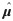
Dependence of popular impact metrics on the values of μ^ and number of publications N
p for researchers in chemistry.We generate 1000 synthetic datasets for each of 20 values of μ^ from 0.5 to 2.0, inclusive, and for N
p = 50 (blue) and N
p = 200 (red). We use the average σ^ of all researchers in chemistry. For each pair of values of μ^ and N
p we calculated the average value and 95% confidence interval. The colored circles indicate the observed values of the corresponding metrics for chemistry, which have been grouped according to their number of publications N
p. Values for 22 researchers fall outside of the figures’ limits: 3 in A, 7 in B, 4 in C, 3 in D. (A) The total number of citations depends dramatically on N
p, which in turn depends strongly on career length, and can be influenced by just a few highly cited publications. (B) The average number of citations is less susceptible to changes in N
p but can still be influenced by a small number of highly cited publications. (C) The h-index, like the total number of publications, is strongly dependent on N
p. (D) The median number of citations to publications, like the average, is not very dependent on N
p, and can capture most of the observed behavior.